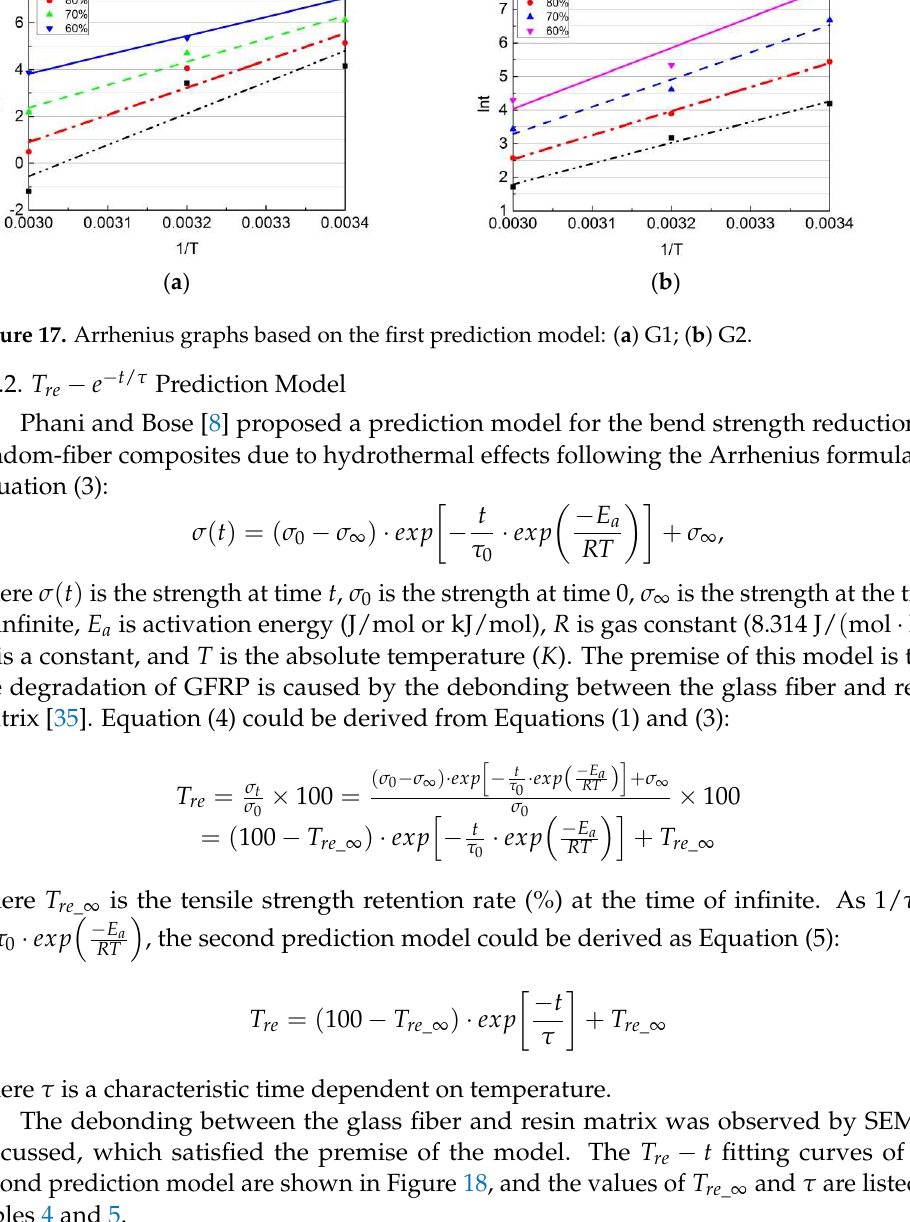
61 Table 3. Determined values of 𝑎 and 𝑏 (G2).